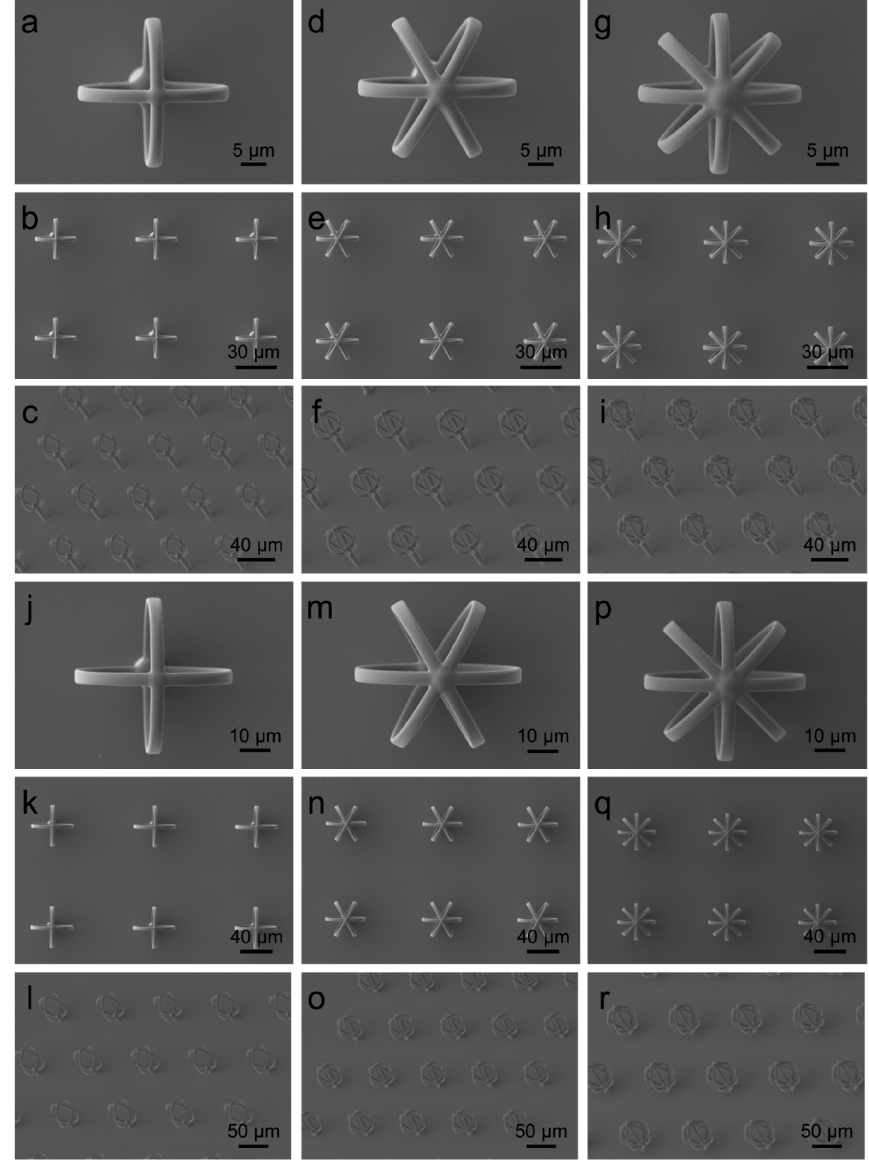
Figure 2. SEM images of the results of the microfabrication of some hairs designs by means of direct laser lithography: hairs with head radius of 15 µm and four ( a – c ), six ( d – f ), and eight ( g – i ) filaments (design number 4, 5 and 6 respectively). Hairs with head radius of 25 µm and four ( j – l ), six ( m – o ) and eight ( p – r ) filaments (design number 10, 11 and 12 respectively). See Figure 1d for all the geometrical parameters of the presented designs.